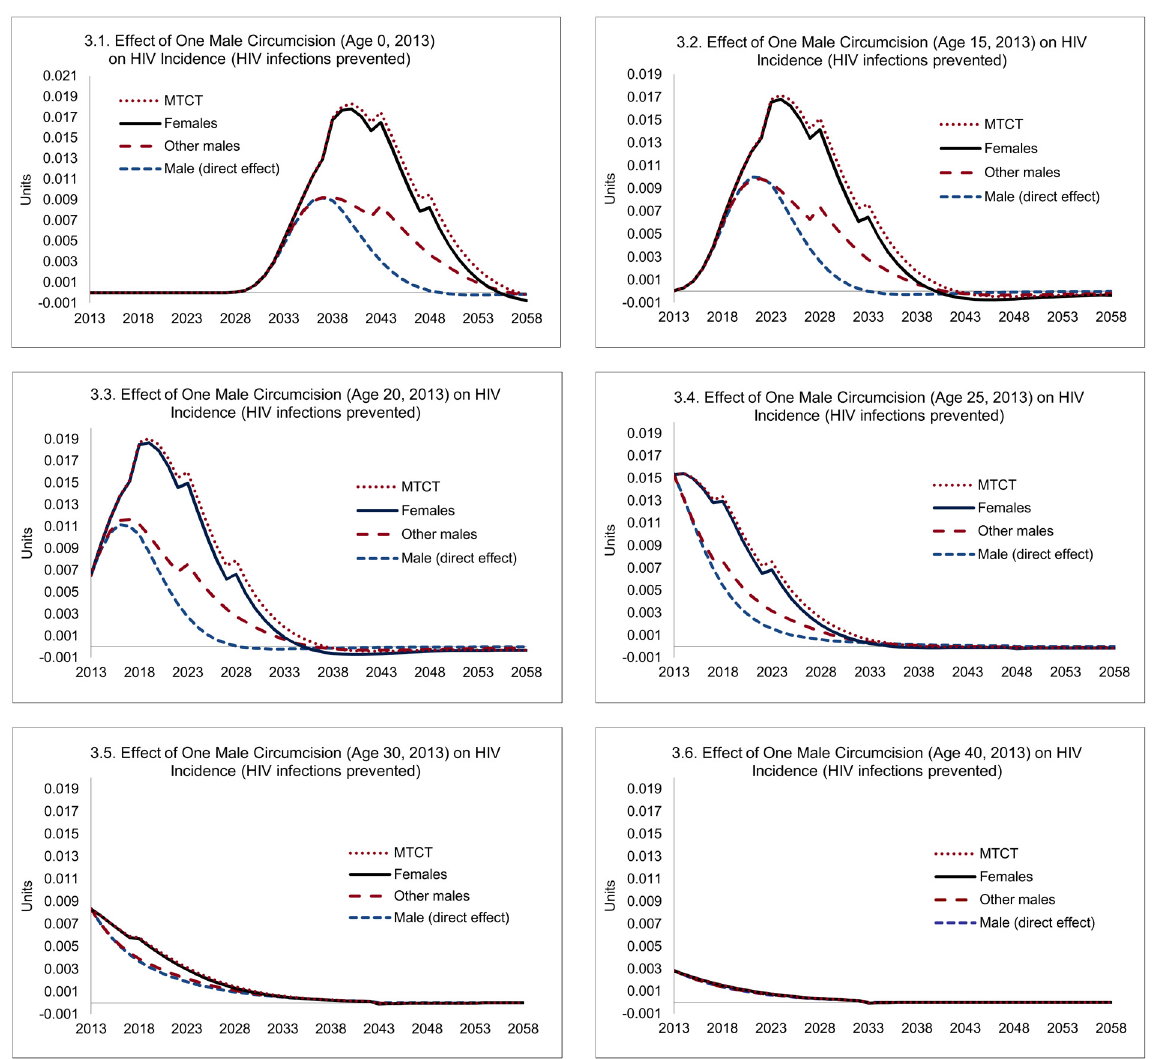
Fig 3. Direct and indirect effects of one male circumcision on HIV incidence. Note: "Male (direct effect)" shows the expected effect on the individual circumcised, "Females" shows the population-level effects among female partners, "Other males" represent population-level effects among males other than the individual circumcised, and "MTCT" stands for HIV infections averted through mother-to-child transmission.